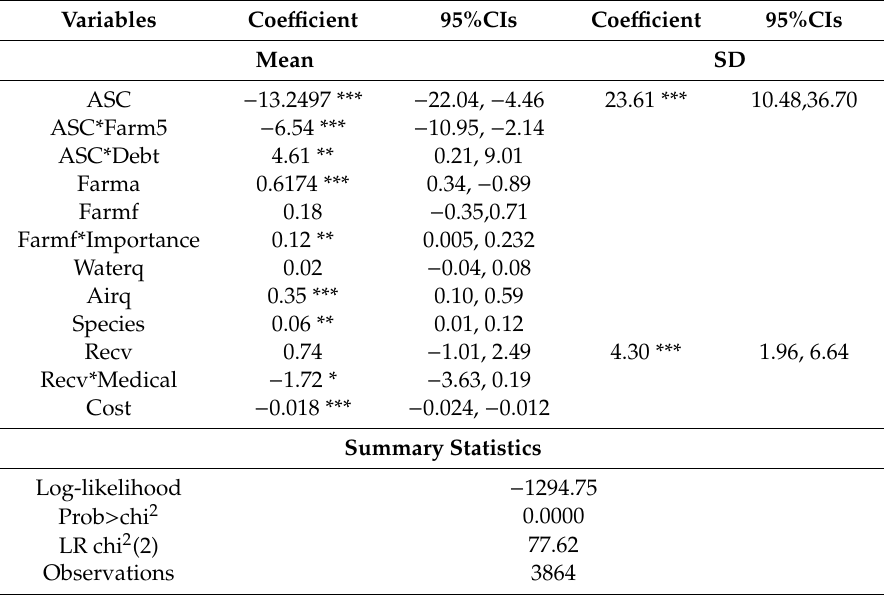
Table 4. Results of mixed logit model. ASC: alternative specific